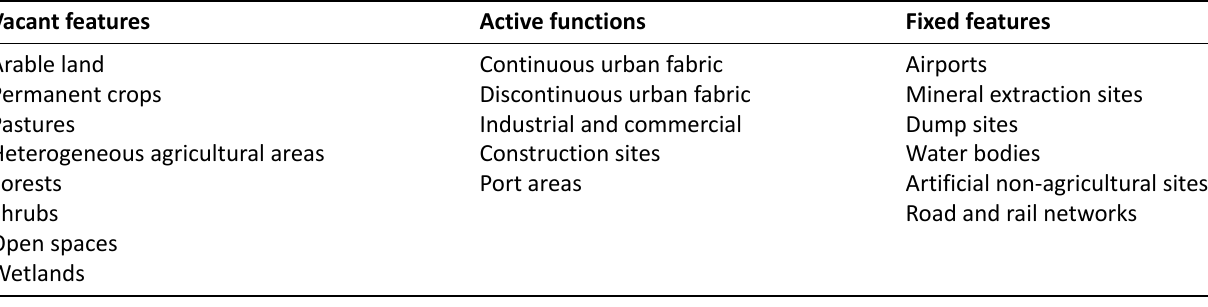
Table 3. Land-use classes for Leipzig-Halle Region. Vacant